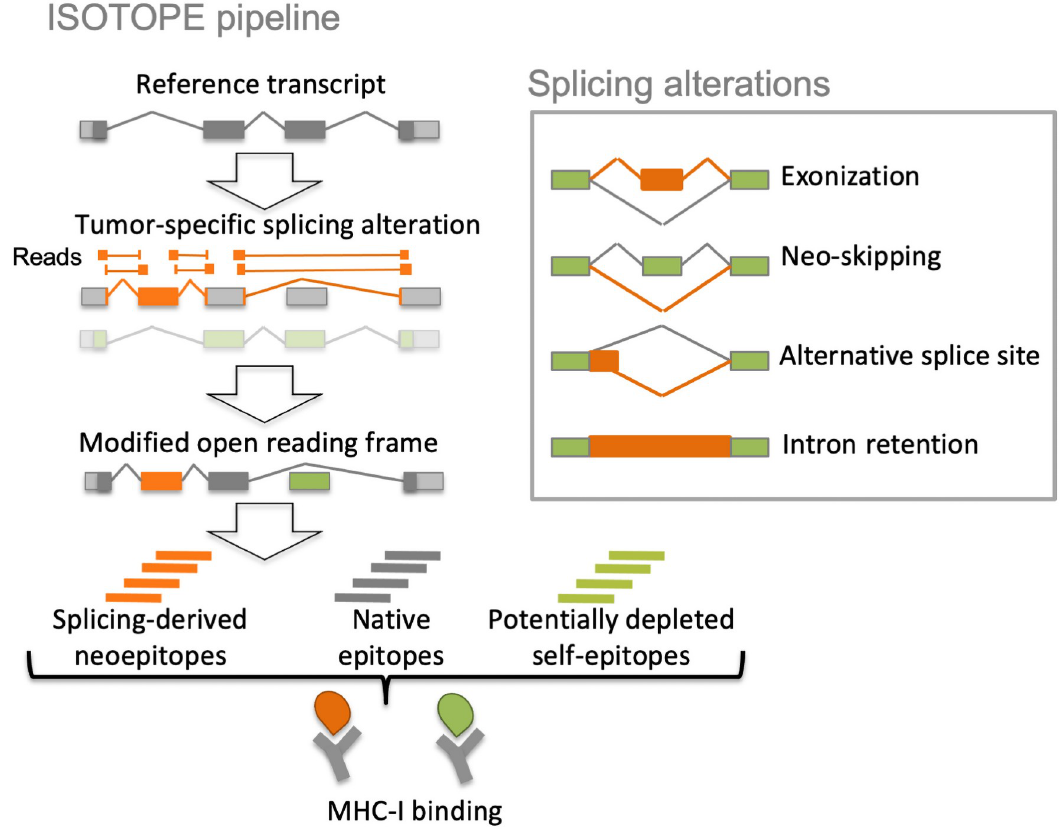
Fig 1. ISOTOPE pipeline. Tumor-specific splicing alterations are defined as significant variations with respect to the exon-intron structures expressed in normal samples and are classified into four different types: de novo exonization, new exon skipping (neoskipping), alternative (5’/3’) splice site, and intron retention. ISOTOPE calculates the modified open reading frame (ORF) from the reference ORF using the splicing alterations, and identifies the candidate splicing-derived neoepitopes and self-epitopes encoded by the reference transcript that would not be present in the modified ORF as a consequence of the splicing alteration. These candidate peptides are then tested for affinity with the MHC complexes (see Methods for details).